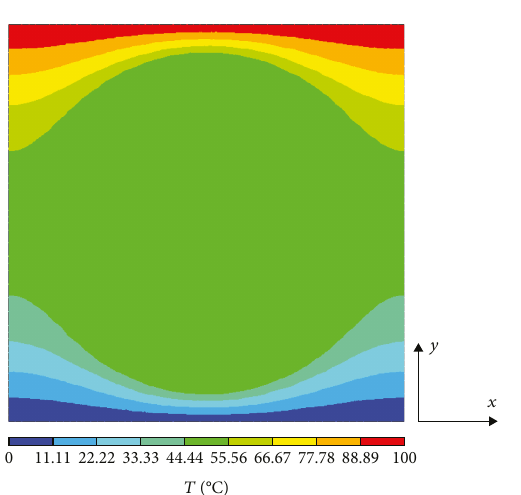
Figure 17: Pro fi le image of the temperature distribution of the wrapper model.